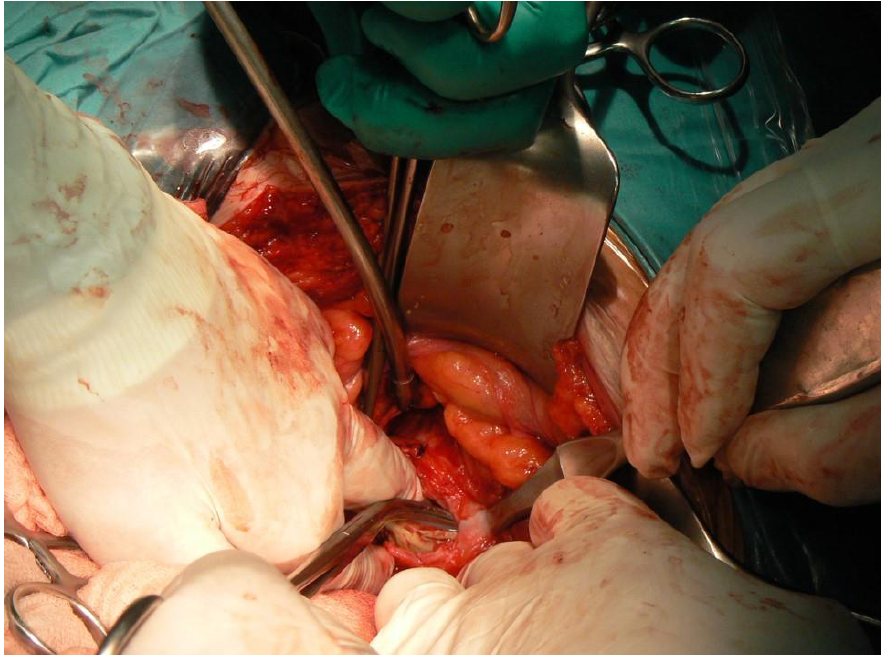
Figure 2. Removal of the acetabular component and bone cement from the pelvic cavity — intraoperative photograph.